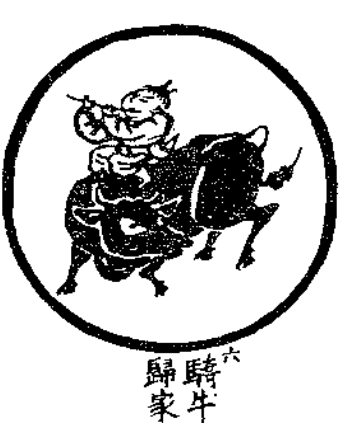
Figure 6. Riding the ox